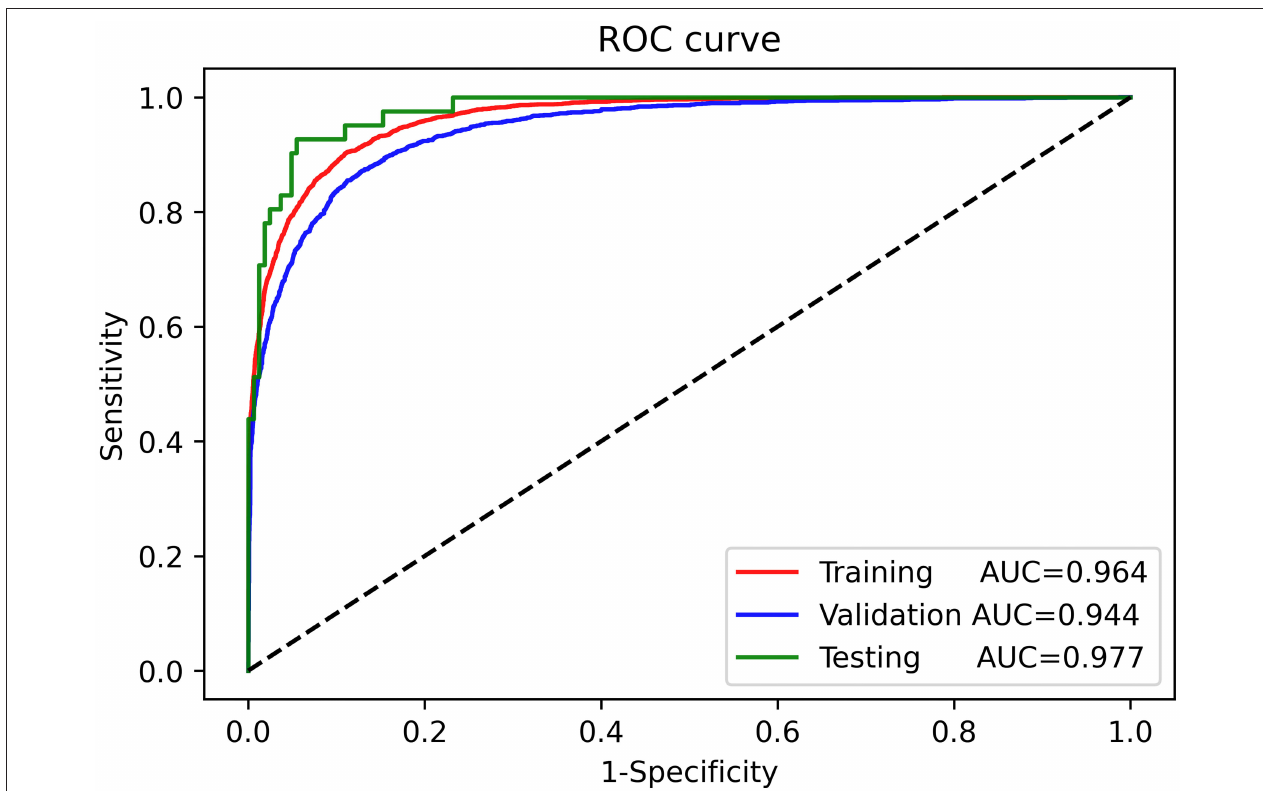
FIGURE 3 | Receiver-operating characteristic curves for automatic diagnosis of acute myocardial infarction in the training, validation, and testing sets.